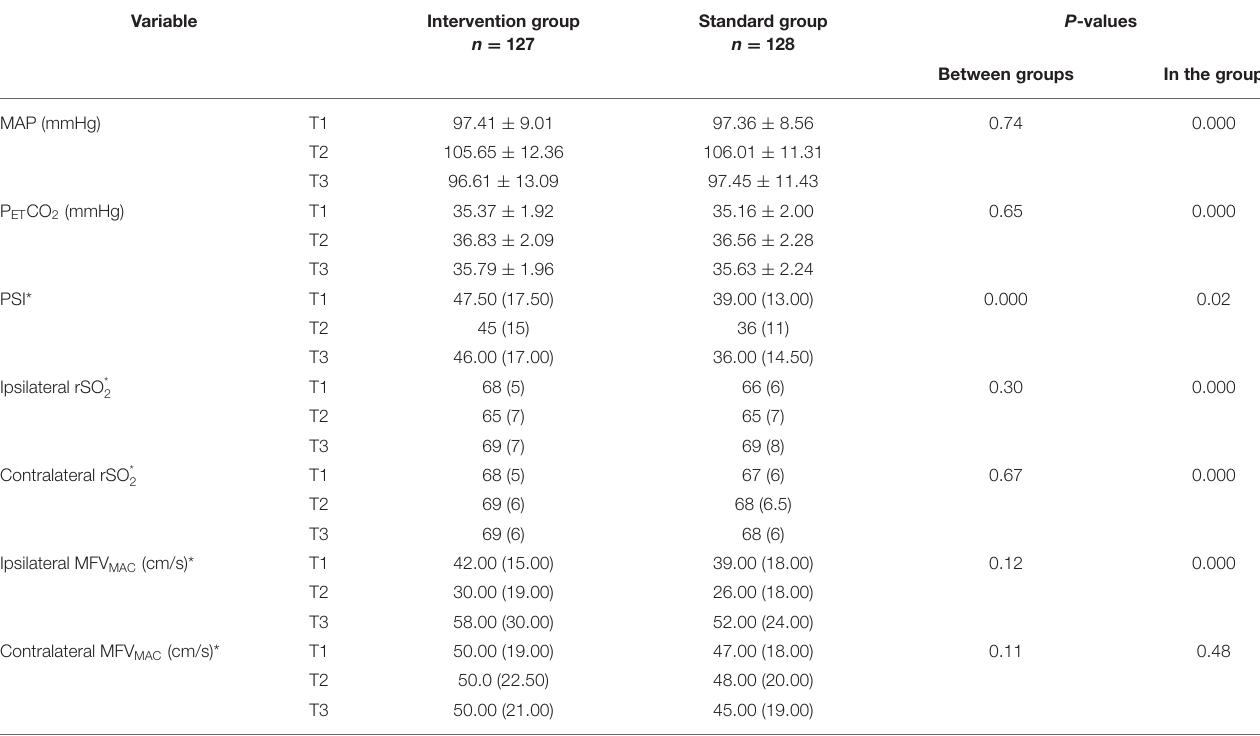
TABLE 4 | Intraoperative monitoring values at different time-points. Variable Intervention group